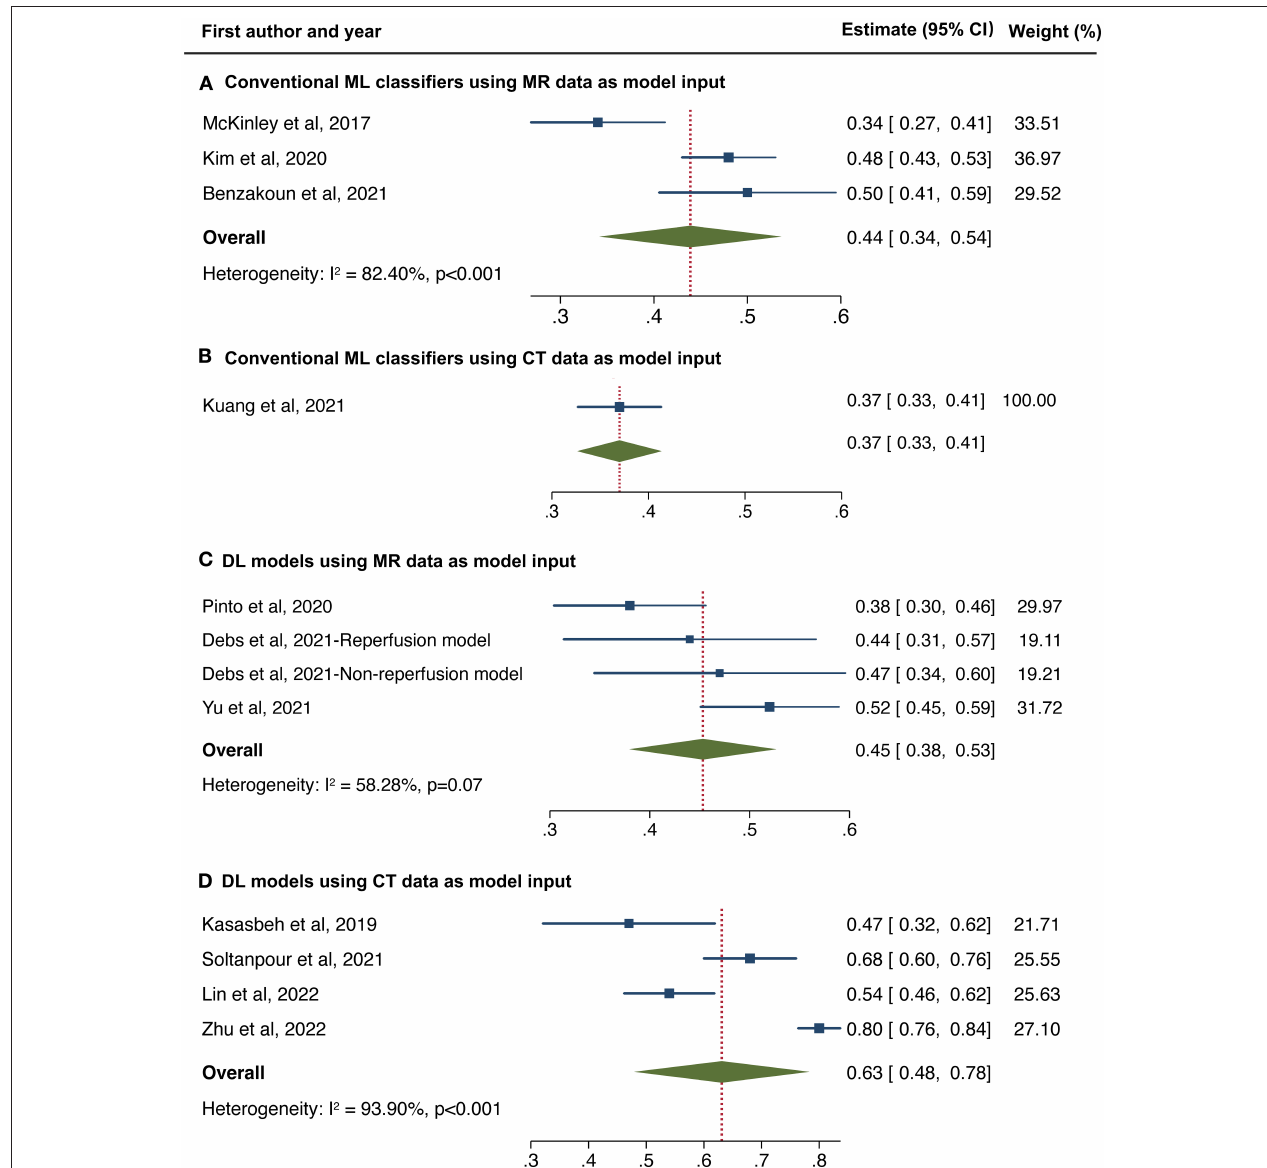
FIGURE 5 | Forest plot of subgroup analyses in conventional machine learning (ML) classifiers using MR data (A) and CT data (B) as model input, and deep learning models using MR data (C) and CT data (D) as model input,